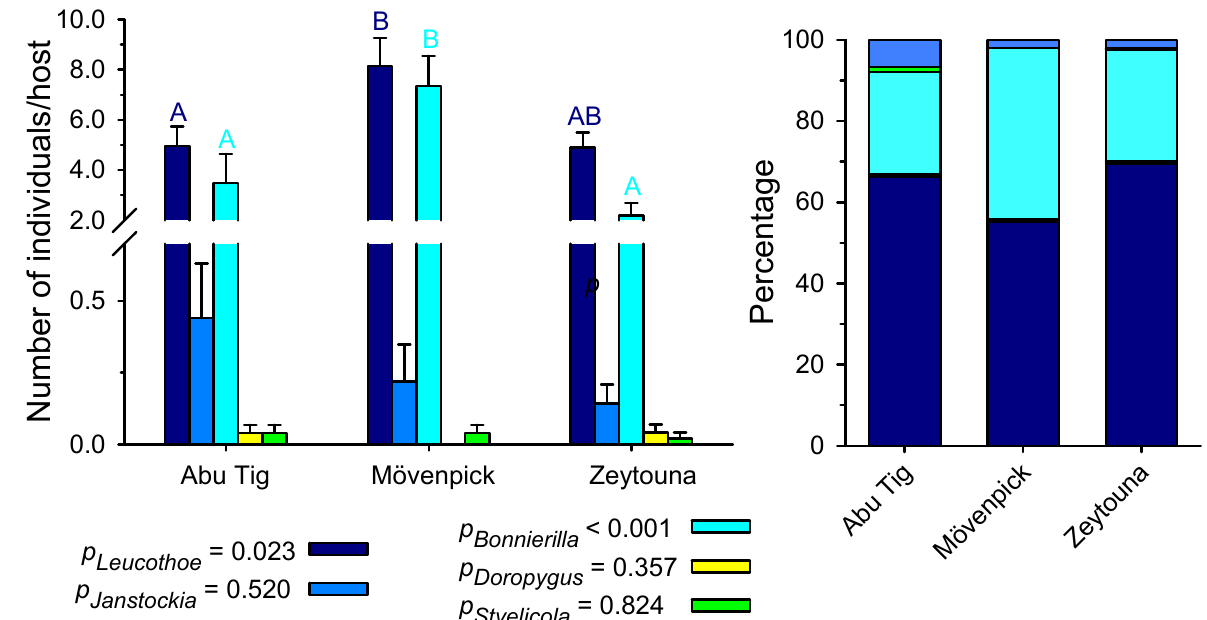
Figure 4. Numbers per host and relative abundances of Phallusia nigra symbionts collected at three reefs from El Gouna, Egypt. Left graph: Bars represent means ± 1 SE and p values are from Kruskal- Wallis tests on individual species. Same letters above bars indicate statistically equivalent means. Right graph: The same data are presented as percentages of total symbiont fauna for reference. These data are not analyzed. Fill colors of bars are as in the left